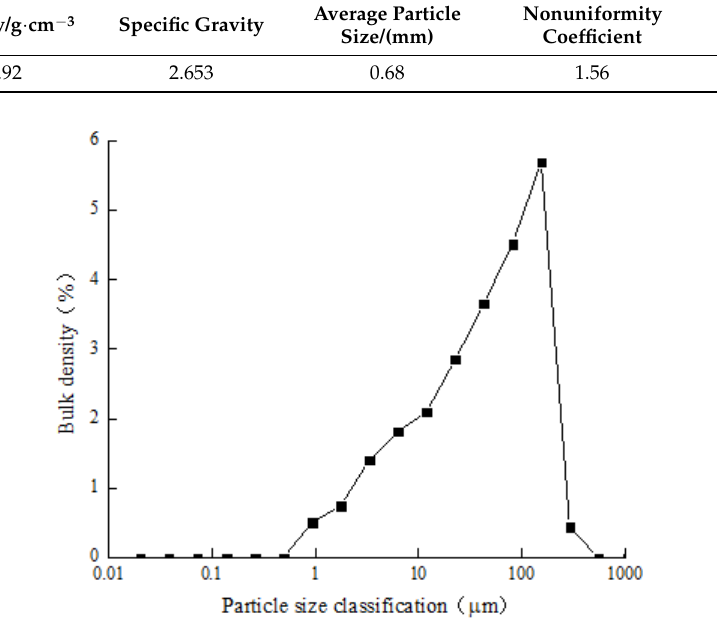
Figure 1. The grain-size distribution of clay.